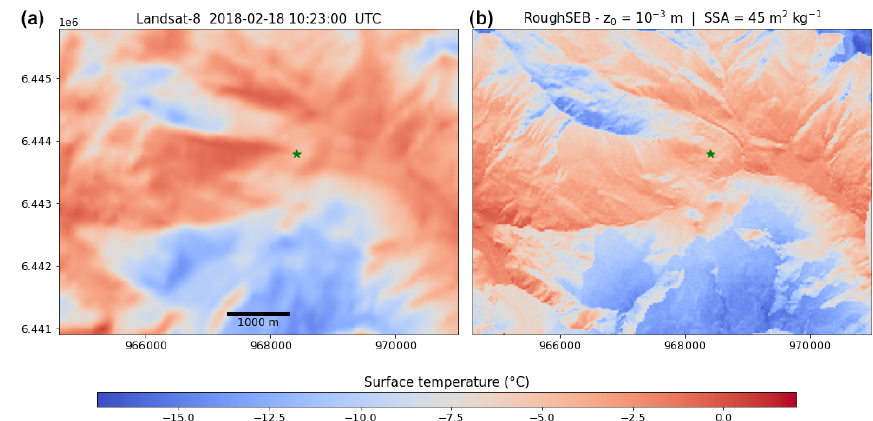
Figure 7. Surface temperature observed by Landsat 8 (a) and simulated by the RoughSEB model (b) in the Col du Lautaret area on 18 Febru- ary 2018. The location of the FluxAlp station is highlighted by the green marker. Projection is Lambert 93 (EPSG: 2154), and the coordinates are in metres.